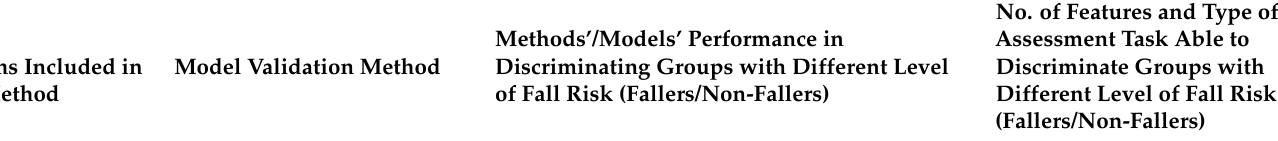
Table 8. Statistical analyses on the sensor-based methods’/models’ abilities to discriminate groups with distinct levels of fall risk. FRE = Fall Risk Estimate.